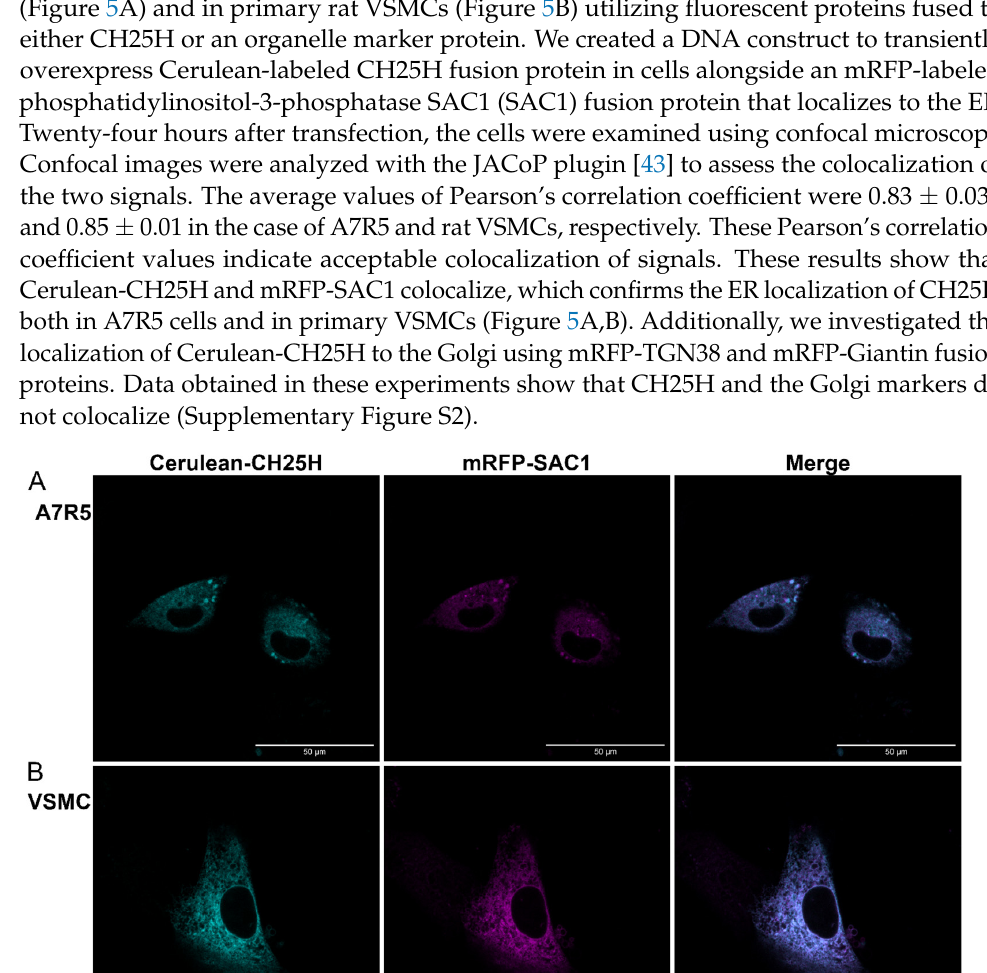
Figure 4. Effect of NOX inhibitor on Ch25h gene expression in rat VSMCs. Serum-deprived VSMCs were treated with 5 μ M DPI or DMSO for 30 min. Following treatment, VSMCs were stimulated with 100 nM AngII or vehicle (Veh) for 1 h. Ch25h mRNA levels are shown relative to Gapdh . Values are plotted as the mean ± SEM of n = 5 independent experiments. Data were analyzed using multiple linear regression, ns (not significant).